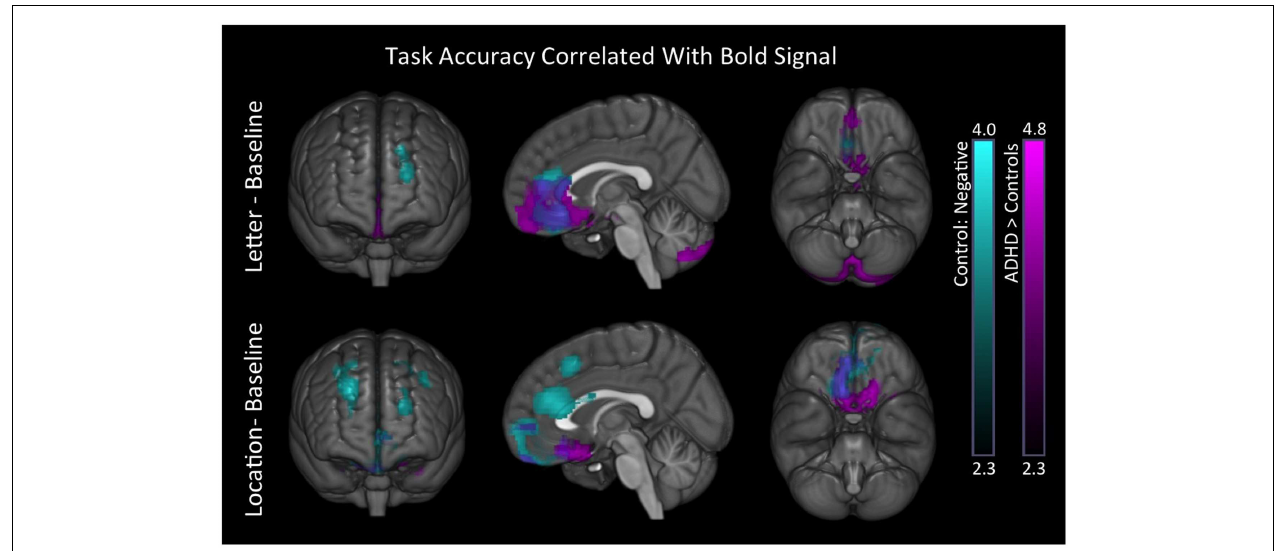
(blue).We also found significant group differences in these same regions for the ADHD minus controls contrast (purple). Images are thresholded using a voxelwise threshold of z = 2.3 and a cluster size probability of p <